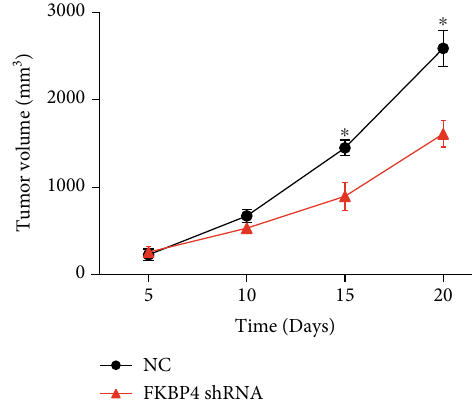
Figure 9: FKBP4 promotes NSCLC growth in vivo; N = 3 , ∗ P < 0 : 05